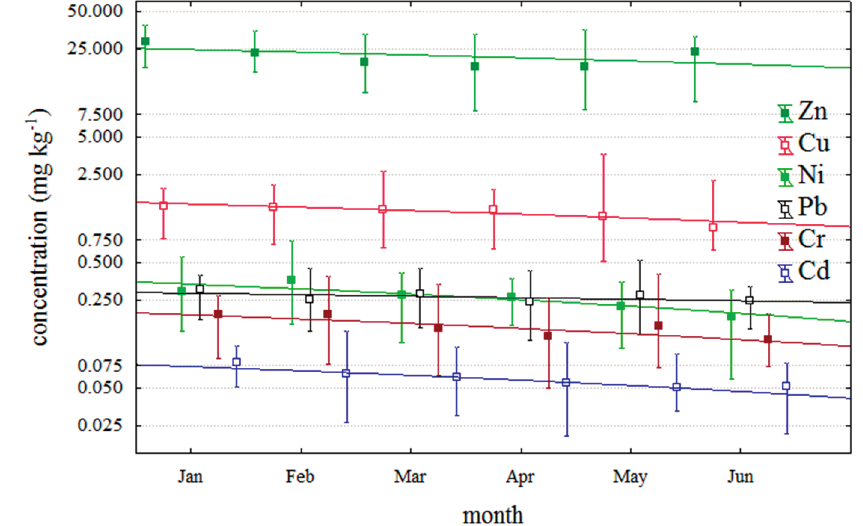
Figure 2. Metal concentration in studied blue mussels on the period from January to June 2011. All samples are DSP